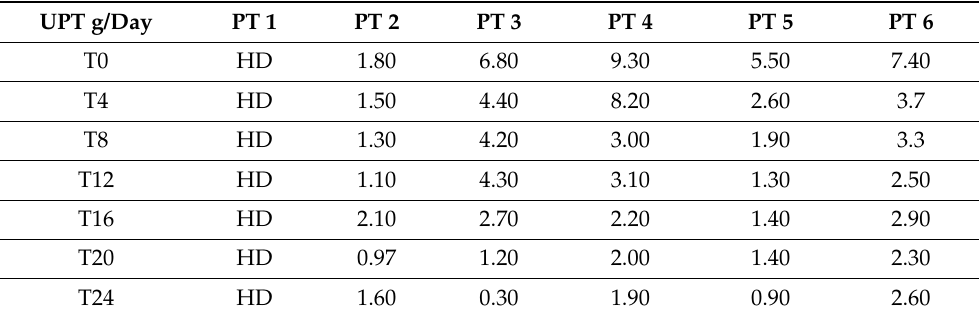
Table 3. Proteinuria values of all patients all of the time during the treatment. TO: pre-treatment, and every other four infusions.